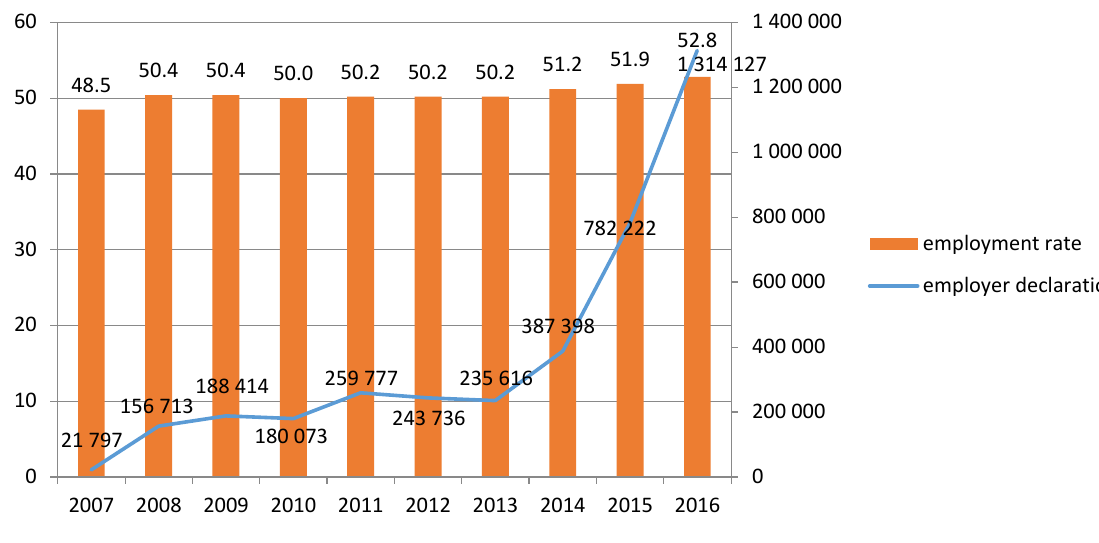
Source: CSO (2017a) and Ministry of Family, Labour and Social Policy